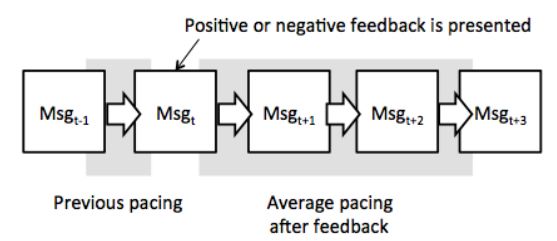
Table 13. Differences in pacing after feedback exposure by milestone. GC means Group cohesion; IC means Individual cohesion.